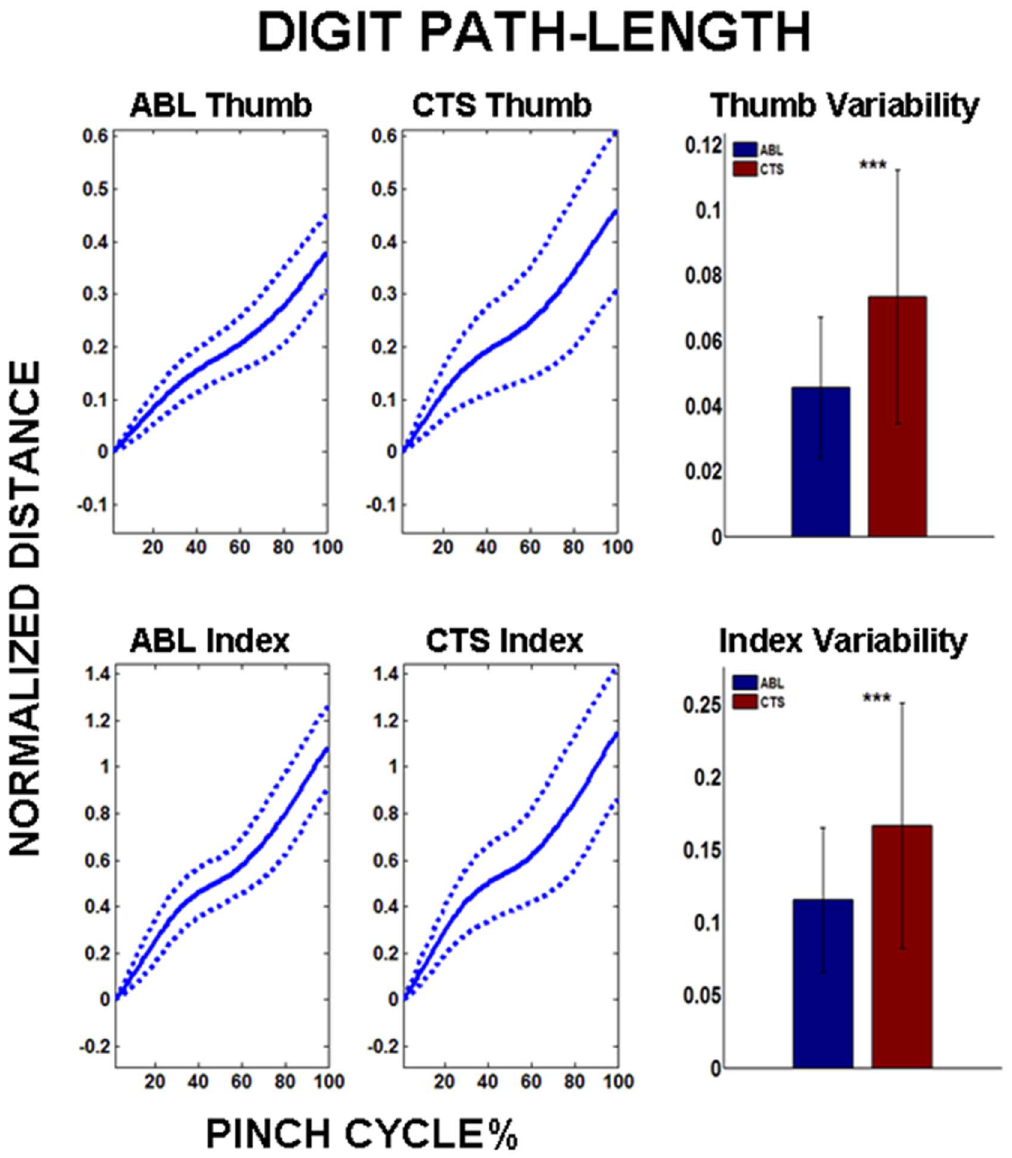
Figure 4. Digit path-length accumulated over pinch cycle. TOP: Mean trajectory and variability of thumb path-length for ABL and CTS groups. BOTTOM: Mean trajectory and variability of index path-length for ABL and CTS groups. Note: ***p , 0.001, Distances self-normalized by subject ‘‘palm width’’.